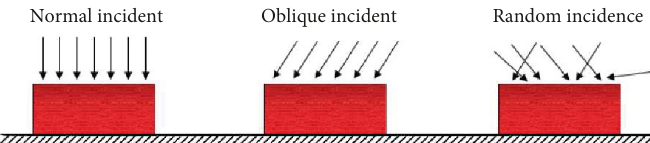
Figure 1: Schematic diagram of three types of